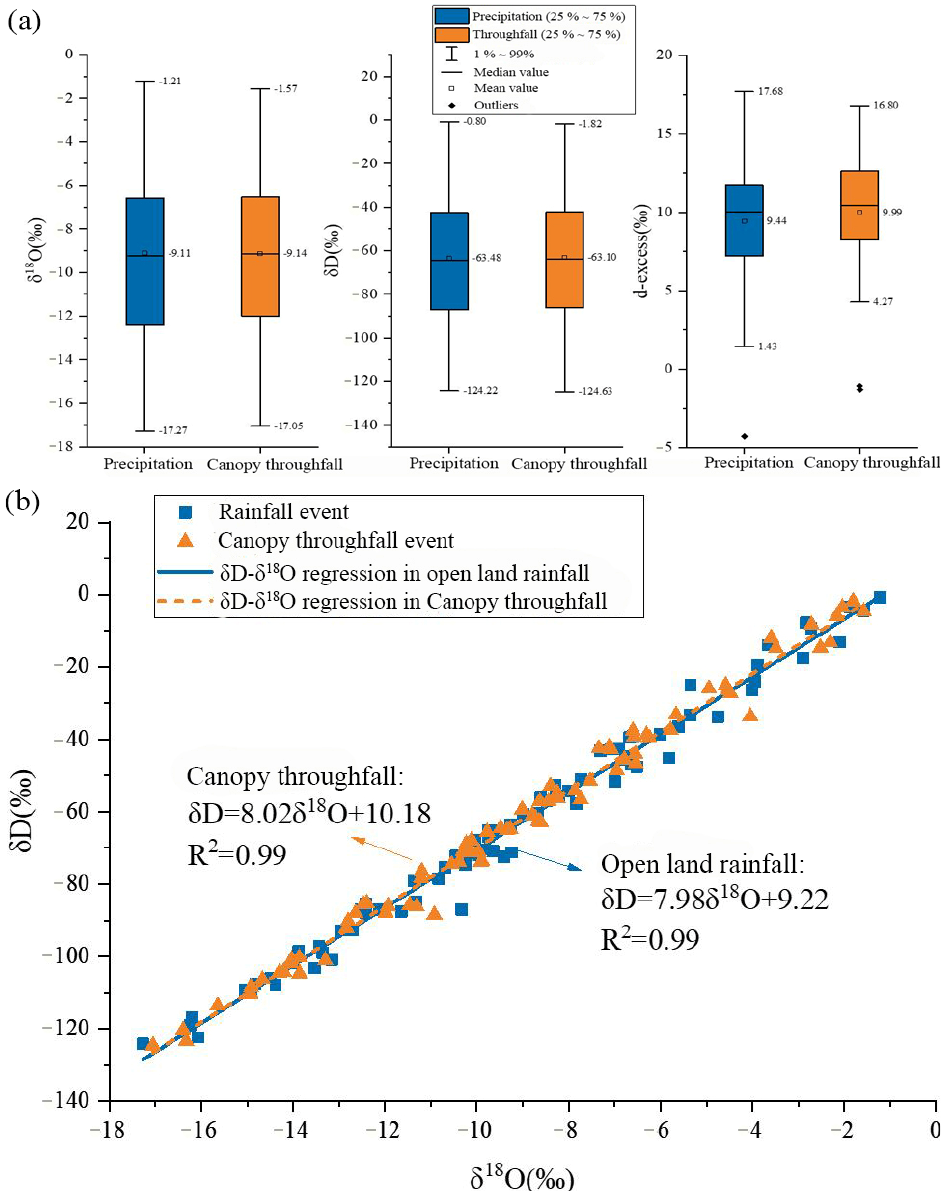
Figure 2. Isotopic comparison between open-land rainfall and canopy throughfall: ( a ) box-plot of δ D, δ 18 O and d-excess; ( b ) δ D- δ 18 O regression lines.